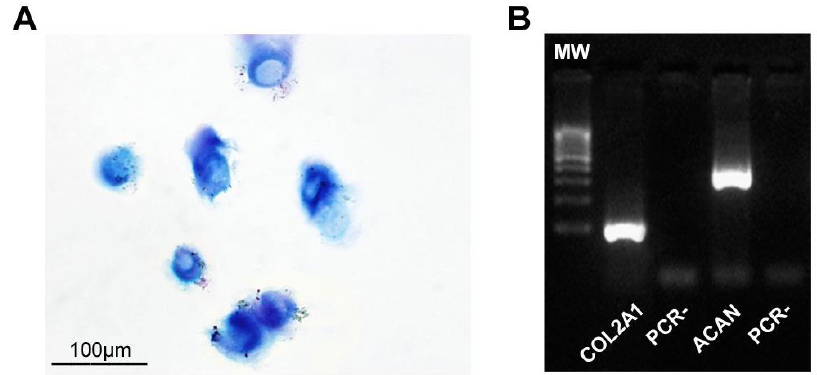
Figure 4. Phenotypic characterisation of cultured HCs. ( A ) Representative image of Alcian – PAS staining of cytospinned HCs (in particular, fluid sample). ( B ) Representative RT-PCR showing chondrogenic marker COL2A1 and ACAN mRNA expression (in particular, fluid sample). Abbreviations: MW, molecular weight; PCR-, negative control.